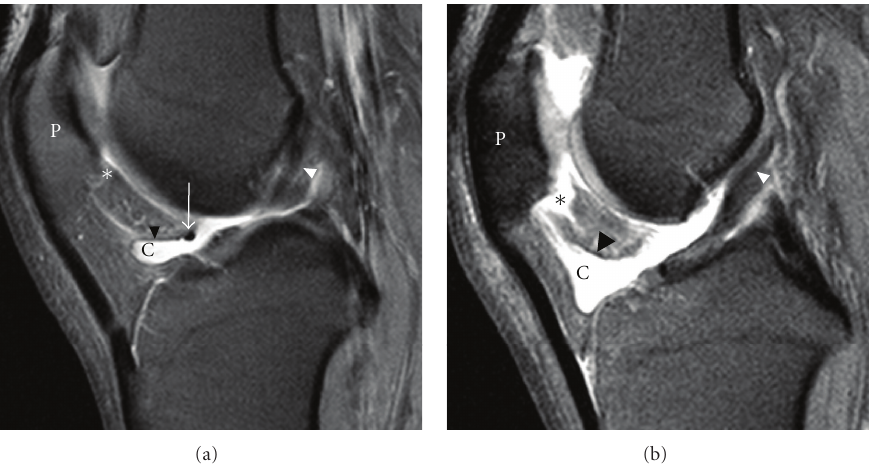
Figure 3: Fluid filled synovial clefts of Ho ff a’s fat pad in the knees of 2 floor layers. In these sagittal proton density fat-saturated images of the right knee in a 43-year-old male floor layers with mild (a) and a 50-year-old male floor layer with moderate (b) e ff usion of the inferior, horizontal Ho ff a’s cleft there is a communication with the superior cleft ( ∗ ) along the ligamentum mucosum (black arrow head). Arrow, anterior transverse ligament; white arrow head, anterior cruciate ligament; P, patella.